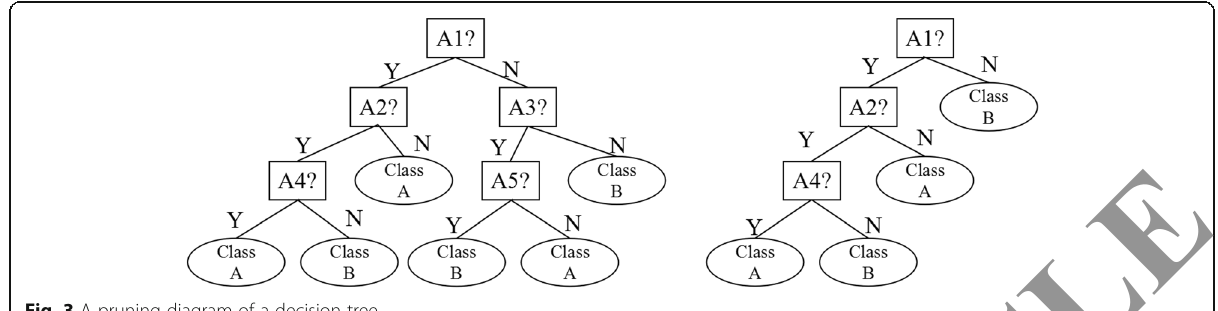
Fig. 3 A pruning diagram of a decision tree